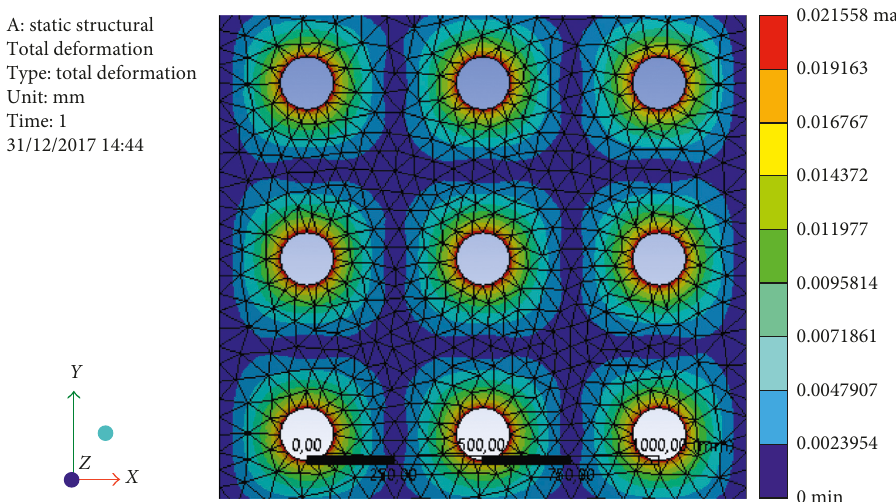
Figure 10: Redistribution and magnitude of displacement around 9 holes drilled in the square